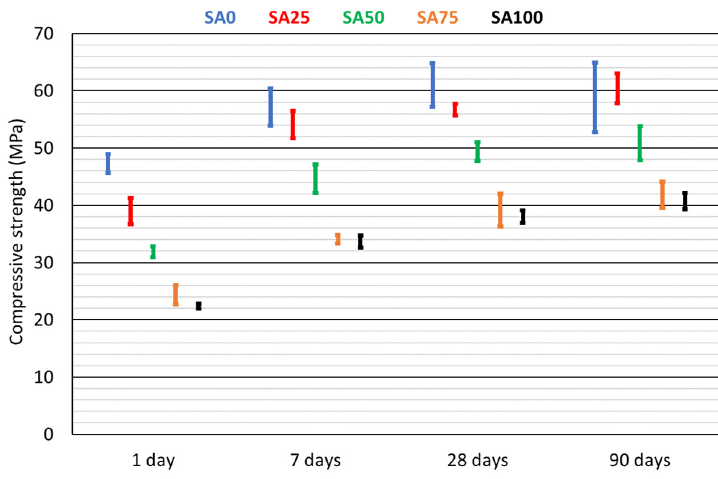
Figure 4. Graph of the confidence intervals of the arithmetic mean.